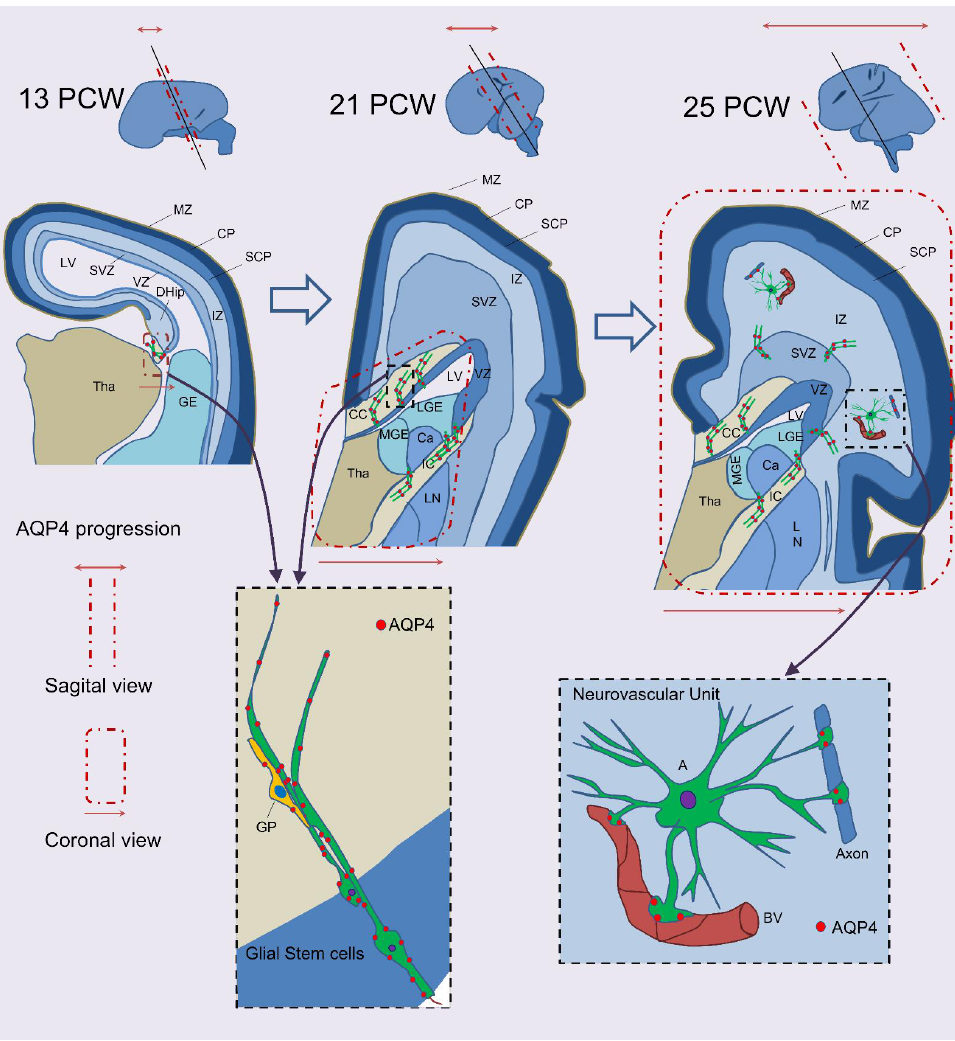
Figure 1. Schematic representation of the expression of AQP4 in brain development. In the telencephalon, AQP4 expression starts in GSCs and GBs and progresses from the para hippocampal VZ toward the glioepithelium of the fimbria of the dorsal hippocampus at 12 – 13 PCW. At 21 PCW, AQP4 has advanced medial to lateral in the coronal view, and medial to polar in the sagittal view. At this point, AQP4 is expressed in the ventricular zone adjacent to the medial portion of the CC, where the GSCs project their cellular process toward CC fibers. GSCs are also found in the LGE and the lenticular nucleus projecting toward the internal capsule. At 25 PCW, the AQP4 is patent cortically, and GSC processes are found projecting from the SVZ to the IZ. Polarized AQP4 expression is located in the astrocyte’s endfeet as a part of the neurovascular unit at the IZ, indicating maturity and functionality. LV, lateral ventricle; MZ, marginal zone; CP, cortical plate; SCP, subcortical plate; IZ, intermediate zone; SVZ, subventricular zone; VZ, ventricular zone; CC, corpus callosum; IC, internal capsule; DHip, dorsal hippocampus; Tha, thalamus; GE ganglionic eminence; LGE, lateral ganglionic eminence; MGE, medial ganglionic eminence; Ca, caudate; LN, lenticular nucleus; GP, glial progenitor; A, astrocyte; BV, blood vessel; AQP4, aquaporin